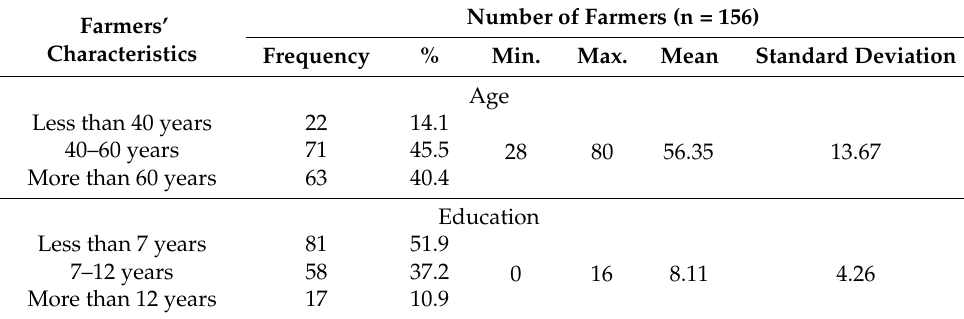
Table 1. Socio-economic profile of the